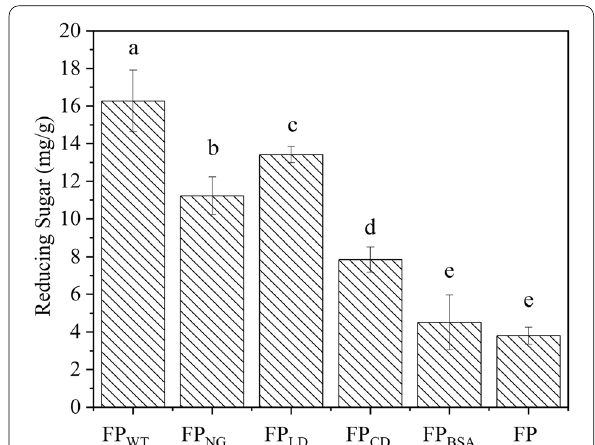
Fig. 6 The synergy between ArCel5 mutants and fungal cellulase in the hydrolysis of filter paper. All reactions were done in 50 mM acetic acid–sodium acetate buffer (pH 5.0) at 55 ℃ with shaking 120 rpm over 24 h. The final concentration of filter paper treated in different ways was all 10 mg/mL, and Trichoderma reesei cellulase was 20 µg/ mg substrate. The FP BSA treated by fungal cellulase was used as reference experiment. Error bars show the standard deviation of three independent